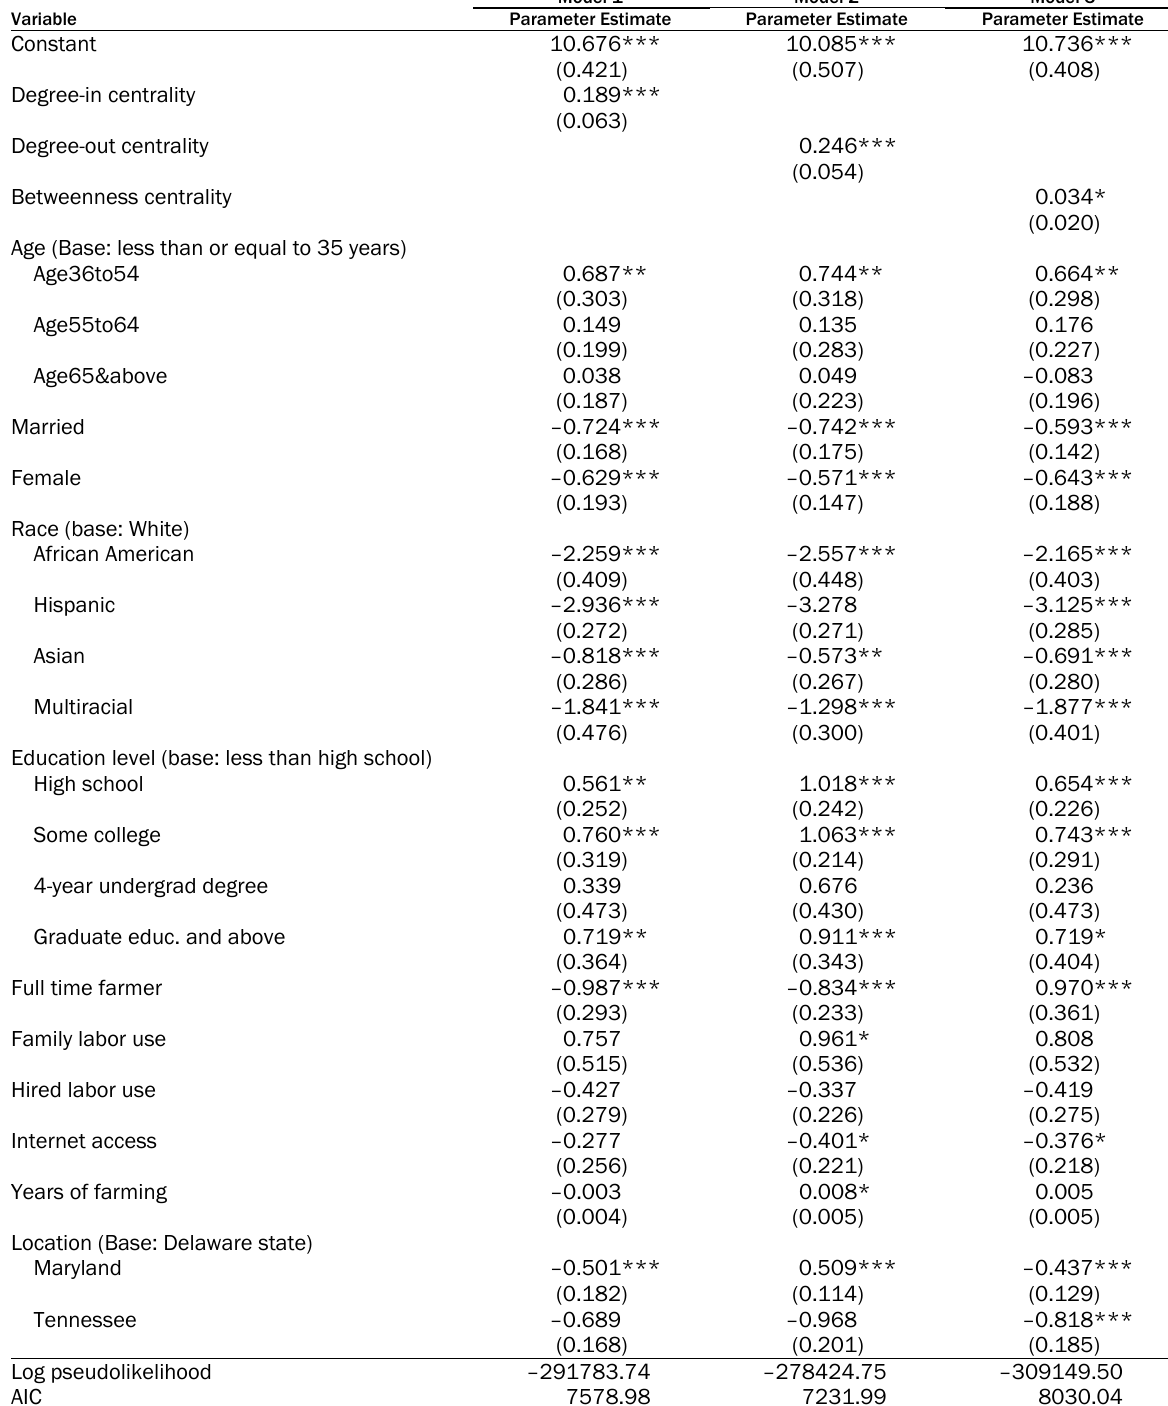
Table 4. Equations Estimating the Effect of Network Centrality on Farm